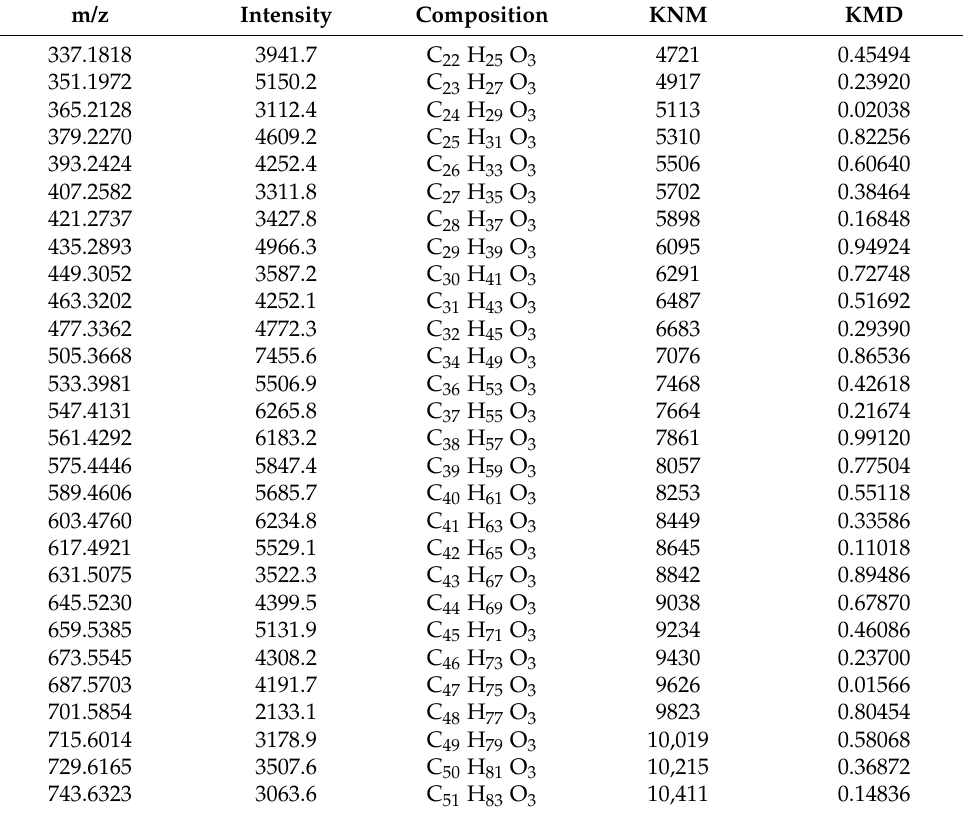
Table 1. Homologous series of O 3 class with <Z> = −